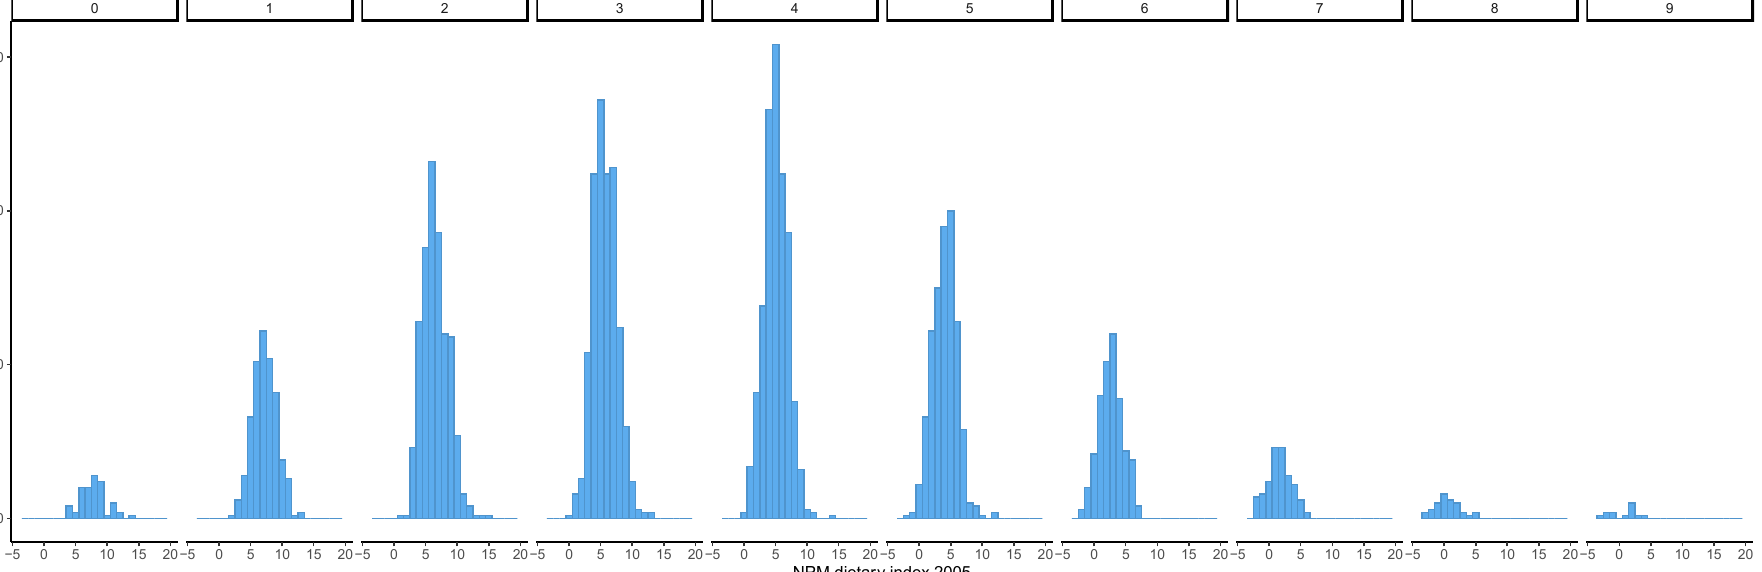
Figure 3. Distribution of the NPM dietary index 2005 by the number of recommendations underpinning the EWG achieved. The NPM dietary index was calculated as the weighted average of NPM for all foods included in each individual’s diet. The EWG score was calculated as the total number of recommendations underpinning the EWG that were met by each individual’s diet. The distribution of the NPM dietary index calculated for individual diets was plotted stratified by level of the EWG score (0–9). EWG, Eatwell Guide; NPM, nutrient profiling model.